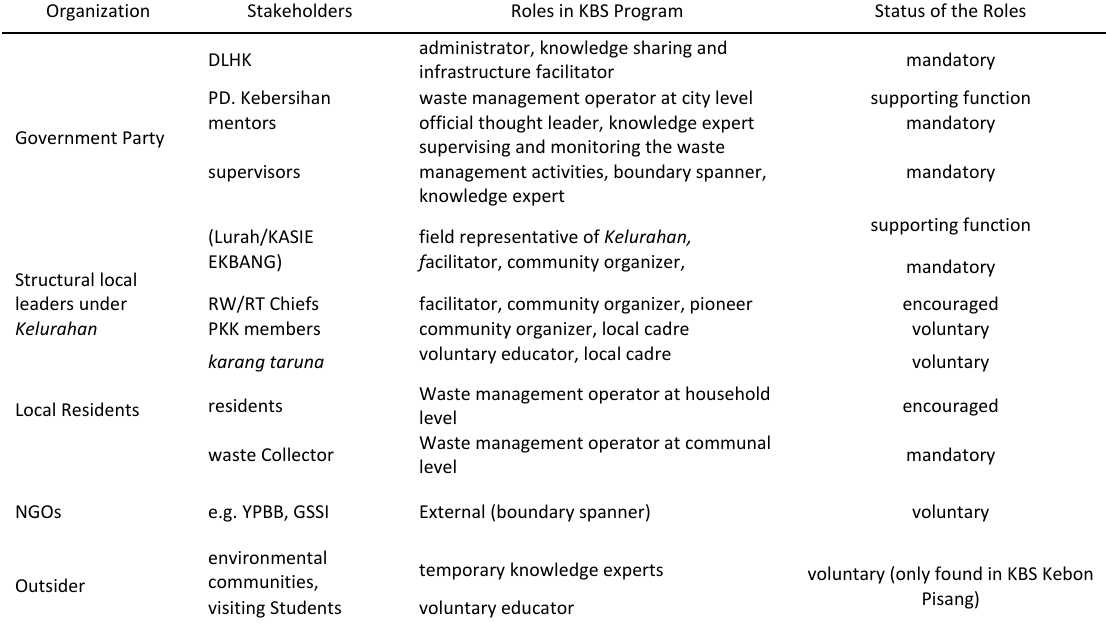
Table 2: KBS Program stakeholders